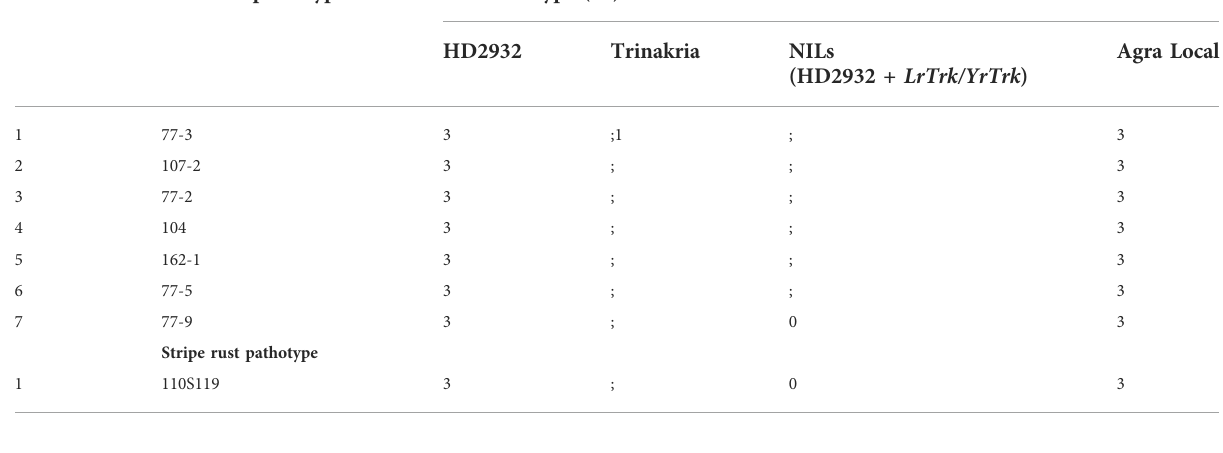
TABLE 2 Response of recurrent parent HD2932, donor parent Trinakria, NILs (HD2932 + LrTrk/YrTrk ), and susceptible check Agra Local toward leaf and stripe rust pathotypes. S. No.